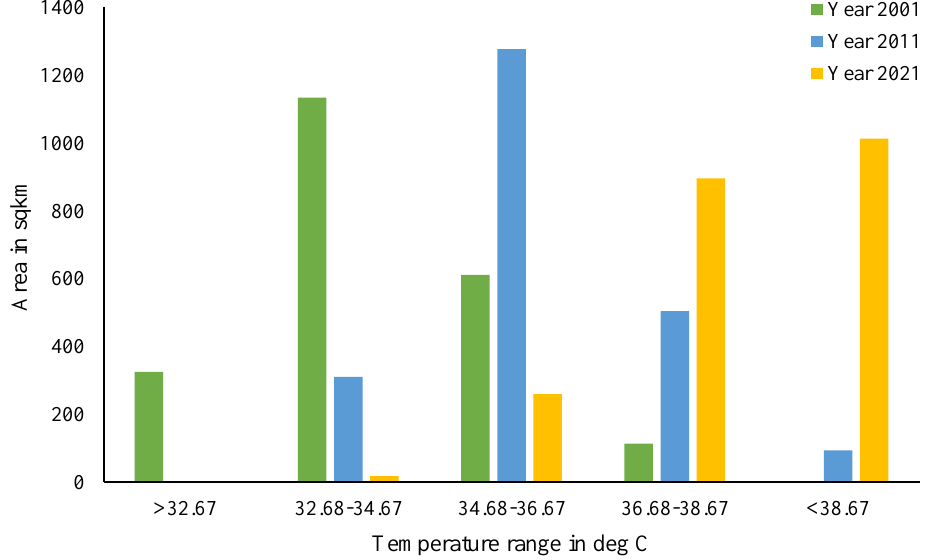
Figure 13. Land surface temperature assessment bar diagram of ten field reference locations of non- urbanized areas.